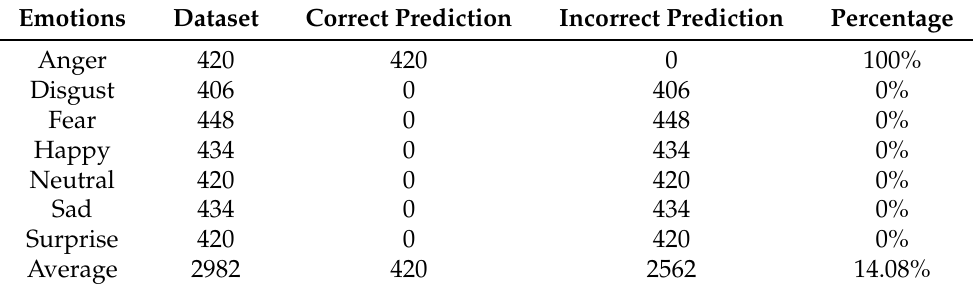
Table 20. Cross dataset testing result of Model 2 after 10 epochs.